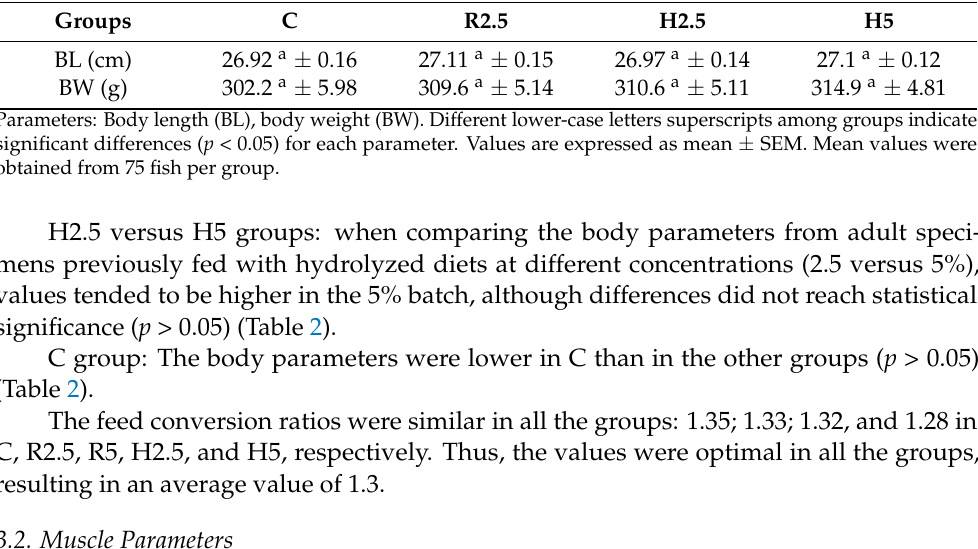
Figure 1. Transverse sections of the white muscle of commercial-size gilthead sea bream (1.6-year- old adult specimens), from C ( a ), R2.5 ( b,c ), H2.5 ( d ), and H5 ( e,f ) groups. Hematoxylin-Eosin stain- ing. W: white muscle fibres; nW: new white muscle fibres. The white muscle fibres density was higher in the H2.5 and H5 groups ( d – f ) than in the other groups ( a – c ). Bars 100 μ m. R2.5 versus H2.5 groups : when comparing the muscle parameters of the adult speci- mens previously fed with raw versus hydrolyzed diets at the same concentration (2.5%), the hydrolyzed diets increased the values of the transverse area of the white muscle (Table 3). Regarding the muscle cellularity, the raw diets increased the size of the fibres (hyper- trophy values: area and minor axis length of the white muscle fibers) ( p < 0.05) (Table 3, Figure 2a), whereas the hydrolyzed diets increased the hyperplasia values (white muscle fibres number) ( p < 0.05) (Figure 2b) and the fibrillar density (number of white fibres mm - 2 ) (Table 3; Figure 1b–d). Table 3. Muscle growth parameters of adult specimens of Sparus aurata. 1.6-Year-old Sparus aurata Specimens Groups